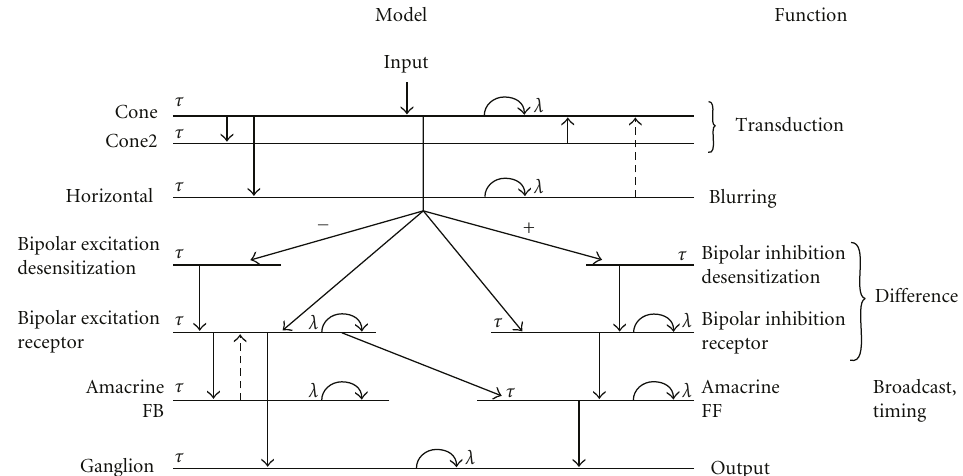
Figure 1: General neuromorphic structure of the light-adapted mammalian retina model. The horizontal lines represent di ff erent layers showing their proper cell names and functions. The vertical dashed arrows denote the inhibitory synapses while continuous arrows show the excitatory synapses. These connections can be varied for each specific retina channels. Each di ff usion layer can be associated with a di ff usion constant (called space constant) and a local time